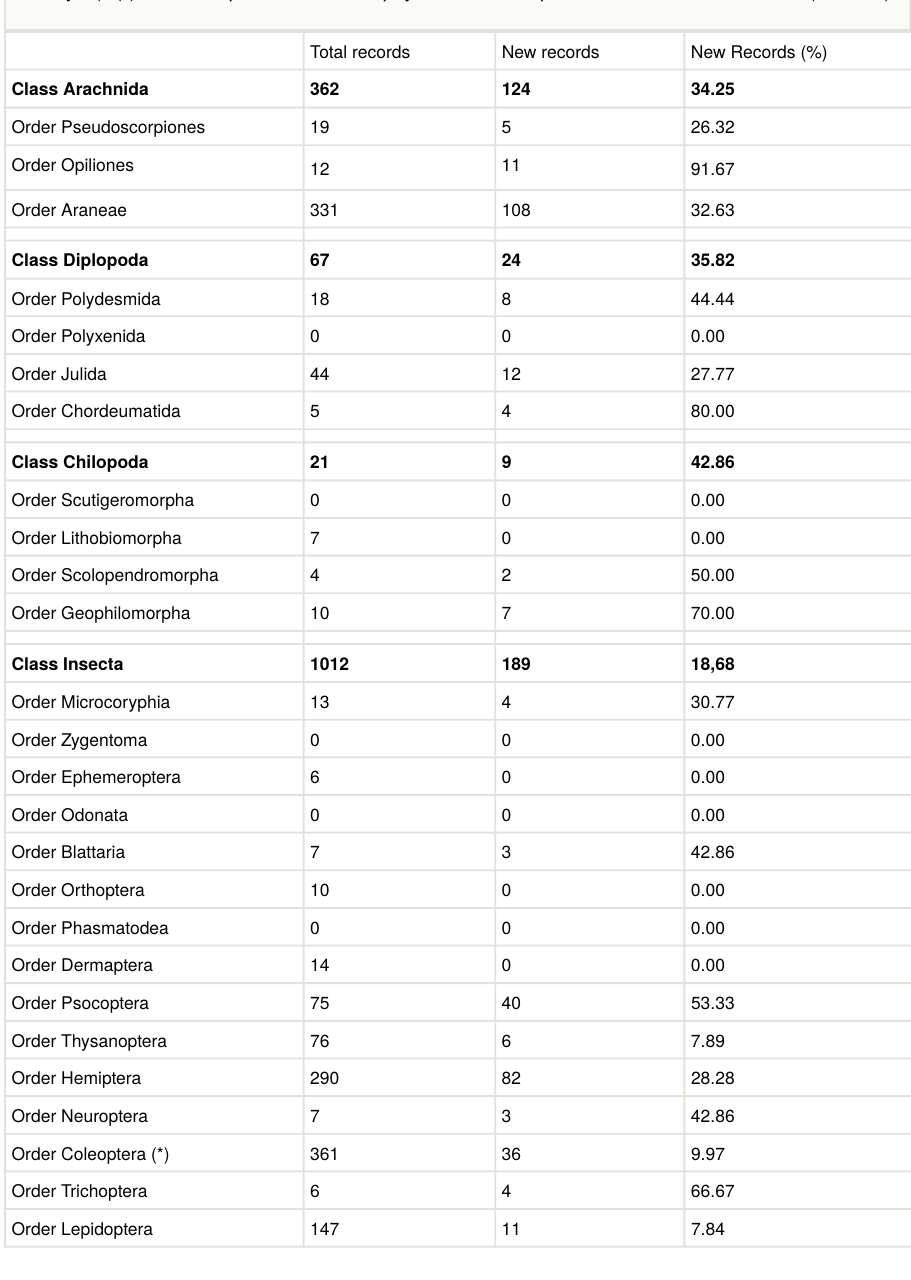
Table 3. Total species and subspecies records for the Azores, new species and subspecies records during this study and increment for the most speciose classes and orders. Values for all islands are added, so richness may be up to 7 times higher than the archipelago's richness (as 7 islands